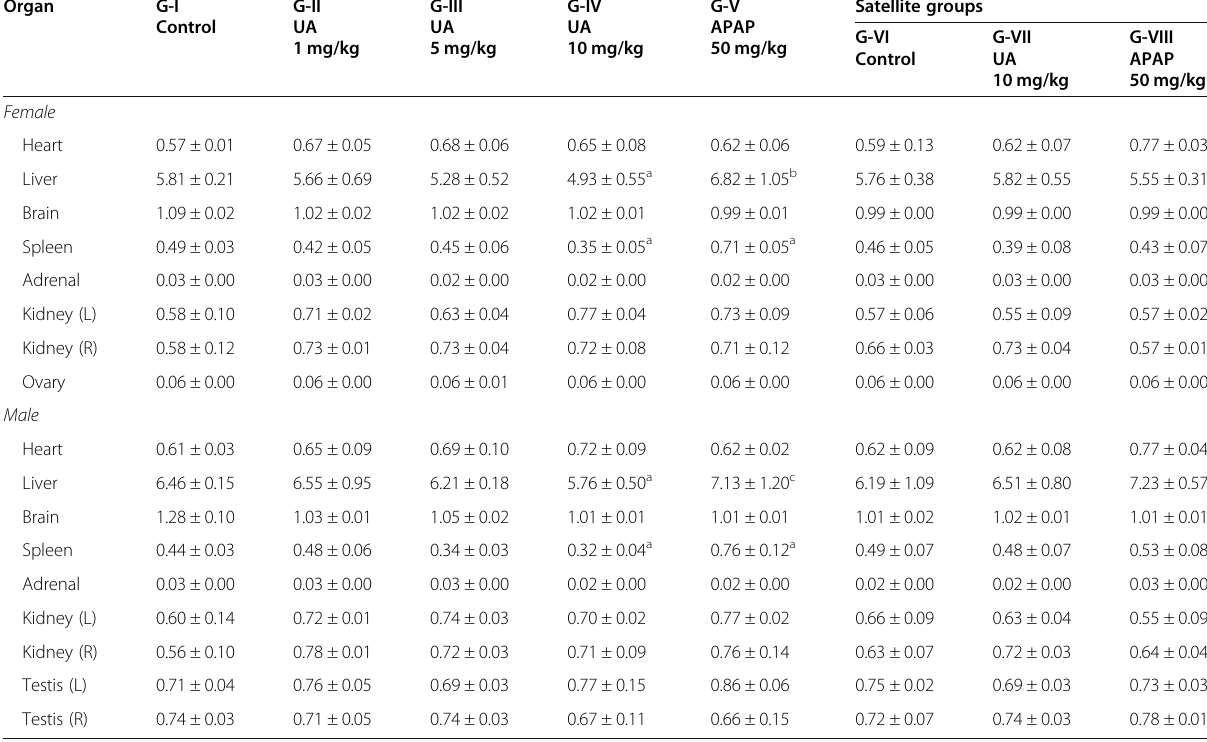
Table 4 Effects of sub-acute oral administration of UA and APAP on relative organ ROW of Wistar rats ( n =